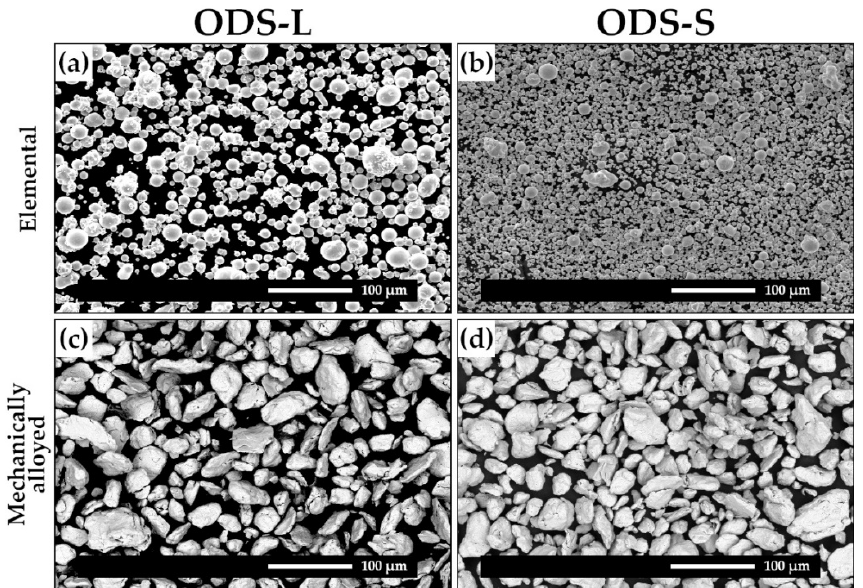
Figure 2. BSE SEM images of the ODS steel powders before and after milling: ( a ) ODS-L pre-alloyed powders, ( b ) ODS-S pre-alloyed powders, ( c ) ODS-L mechanically alloyed powders, and ( d ) ODS-S mechanically alloyed powders. Table 1. Chemical composition (wt. %) of the ODS steel powders after